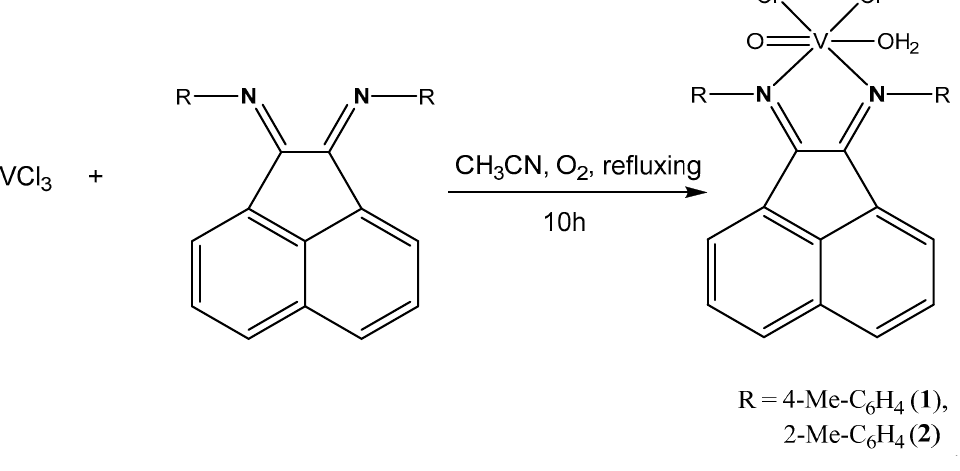
Scheme 1. Complex synthesis Scheme 1. С omplex synthesis reaction.